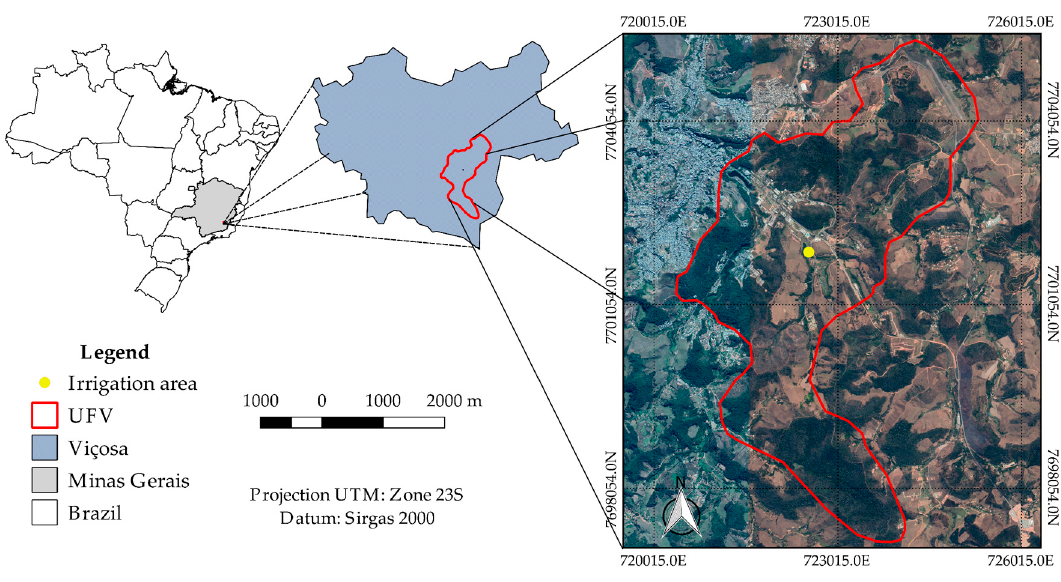
Figure 1. Location of the experimental area.